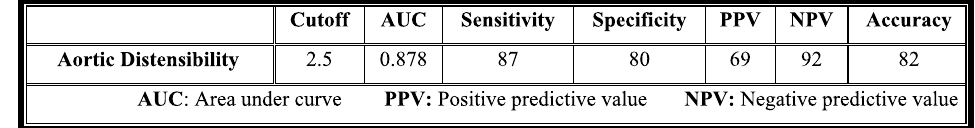
Fig. 2 The receiving operator characteristics curve for aortic